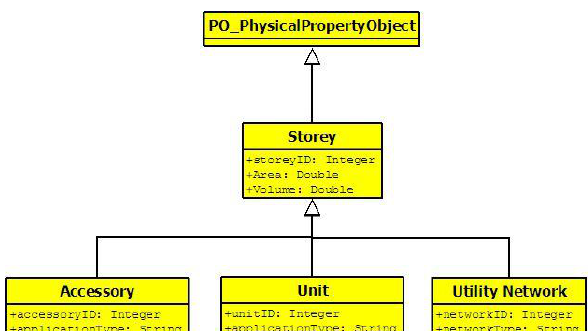
Figure 8. PO_PhysicalPropertyObject Package